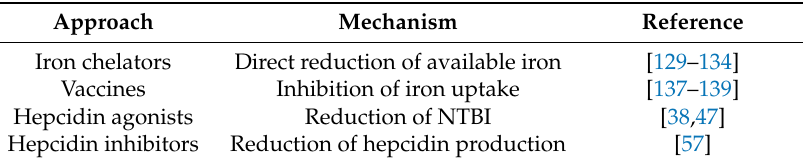
Table 1. Iron-targeted strategies to fight